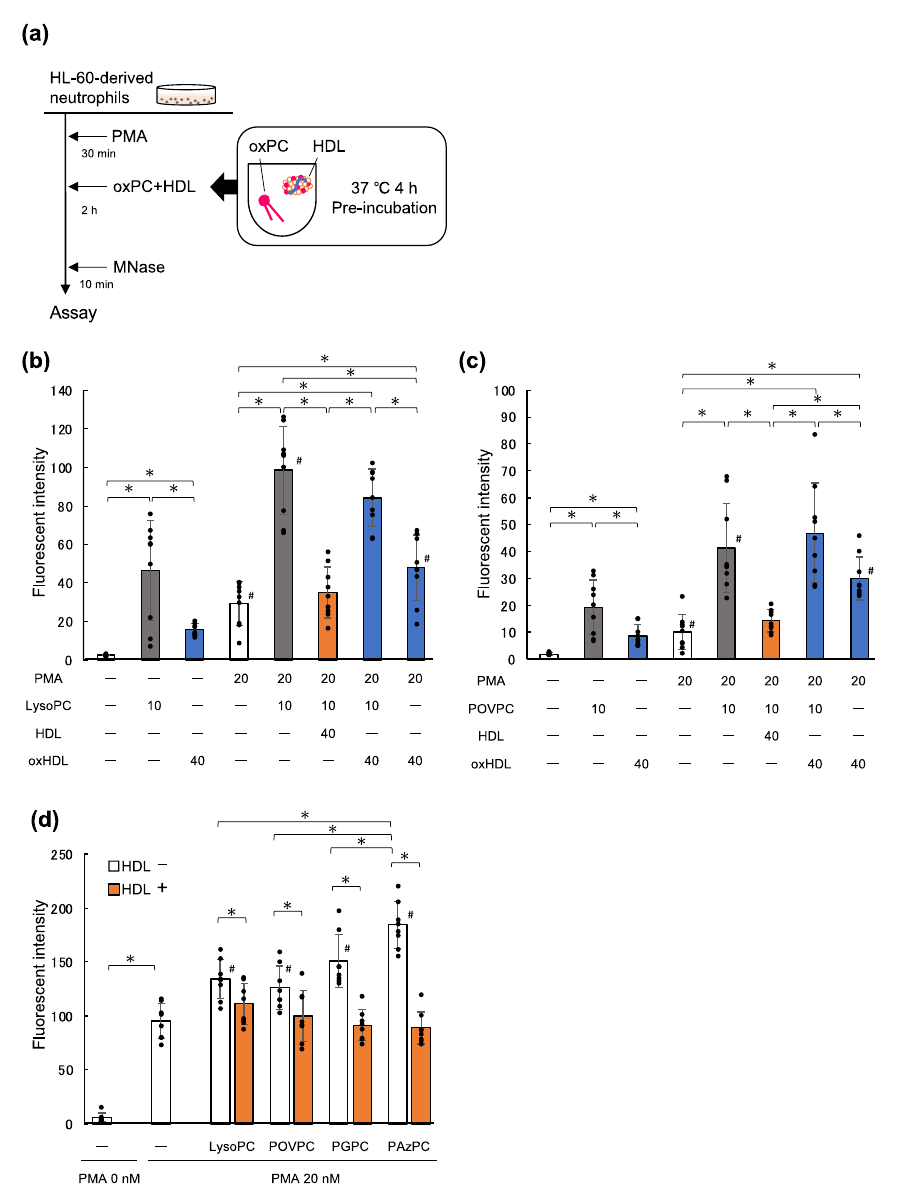
Figure 3. HDL inhibits enhancement of NET formation by lysoPC and oxPCs. ( a ) Experimental scheme. LysoPC or oxPCs were pre-incubated with or without 40 μ g/mL HDL or oxHDL at 37 °C for 4 h. ( b , c ) Either 10 μ M lysoPC ( b ) or POVPC ( c ) were added to the PMA-primed neutrophils in order to enhance NET formation. The data represent the mean ± SD from four experiments, each carried out in triplicate; each dot represents one datapoint. Asterisks indicate statistical significance (* p < 0.05), while sharps indicate statistical significance against the corresponding conditions without PMA (# p < 0.05). ( d ) Similarly, HL-60 derived neutrophil-like cells were stimulated with PMA. Following that, each phospholipid (lysoPC, POVPC, PGPC, or PAzPC; final concentration of 10 μ M), with or without 40 μ g/mL native HDL, was added to the cells, and the cells were incubated with them for 2 h. The data represent the mean ± SD from four experiments, each carried out with duplicates; each dot represents one datapoint. Asterisks indicate statistical significance (* p < 0.05), while sharps indicate statistical significance against cells treated with 20 nM PMA alone (# p < 0.05). HDL, high-density lipoprotein; NET, neutrophil extracellular trap; lysoPC, lysophosphatidylcholine; oxPCs, oxidized phosphatidylcholines; oxHDL, oxidized high-density lipoprotein; POVPC, 1 - palmitoyl-2-(5-oxovaleroyl)-phosphatidylcholine; PMA, phorbol 12-myristate 13-acetate; PGPC, 1- palmitoyl-2-glutaryl-phosphatidyl-choline; PAzPC, 1-palmitoyl-2-azelaoyl phosphatidylcholine.